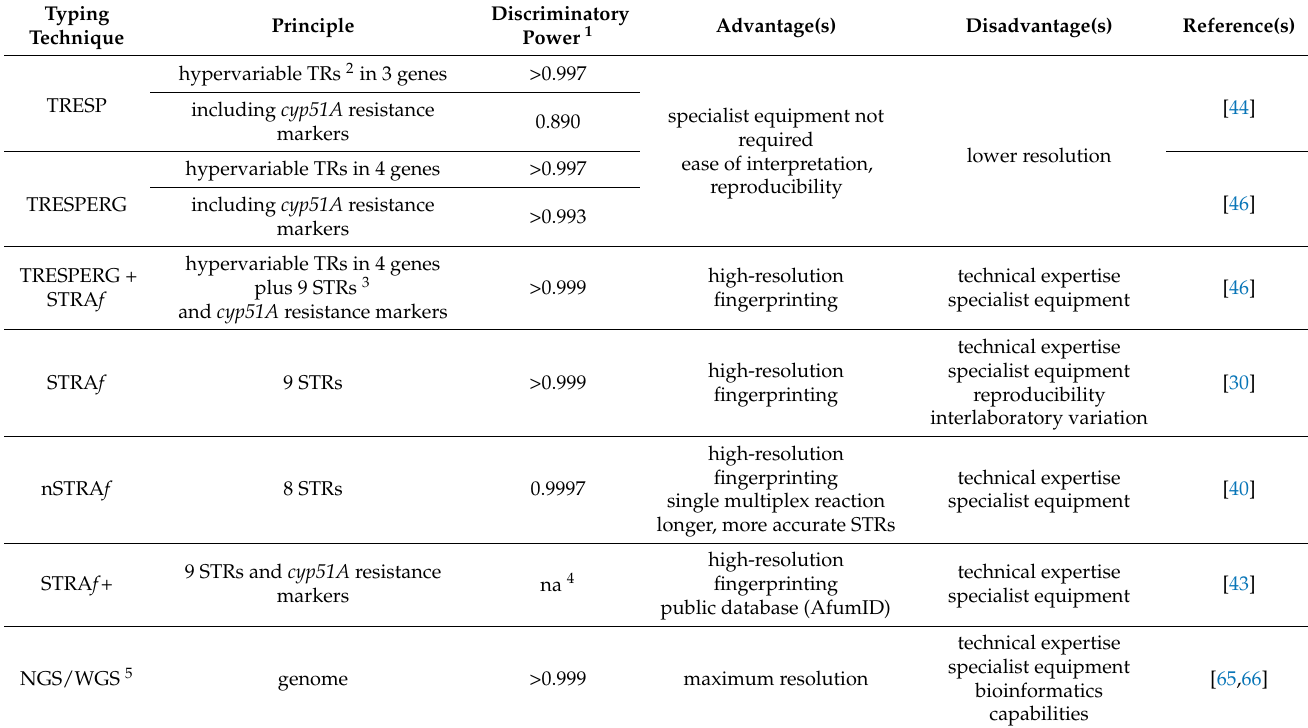
Table 1. Overview of A. fumigatus genotyping approaches and their